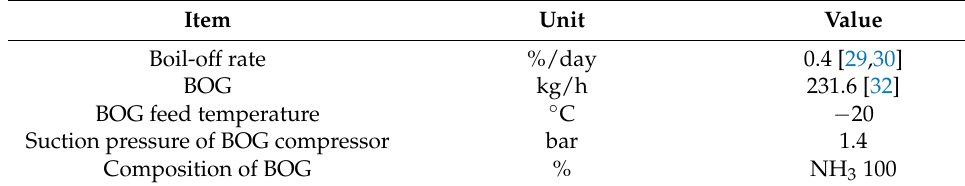
Table 8. Design assumptions of BOG re-liquefaction system.